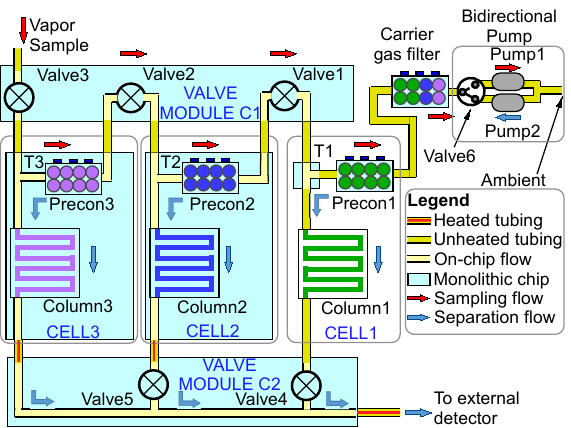
Figure 2. Structural arrangement of the three-cell (PCA3mv) subsystem. Each cell incorporated a T-connector, a preconcentrator, and a separation column. To maximize the analyzable analyte range, the adsorption strength of the preconcentrator and the retentiveness of the separation column in each cell had to be significantly different from those of the other cells. Cell 1, which targeted the volatility range from C 3 to C 5 , incorporated the strongest sorbent in its preconcentrator and the most retentive stationary phase in its separation column. Among the commercially available sorbents, Carboxen™ 1000 (#10477-U, Sigma Aldrich, St. Louis, MO, USA) has the highest surface area of 1200 m 2 /g, hence it was selected for the Cell 1 preconcentrator. Similarly, among the common stationary phases, polydivinylbenzene (pDVB) is a non-polar, porous, and highly retentive material, hence it was selected for the Cell 1 separation column. Cell 2, which targeted C 5 to C 8 , incorporated a moderate sorbent and a less-retentive stationary